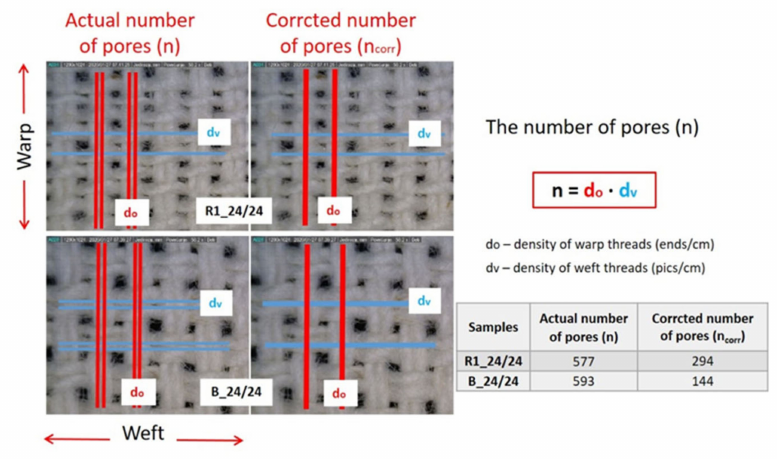
Figure 4. Actual number of pores and corrected number of